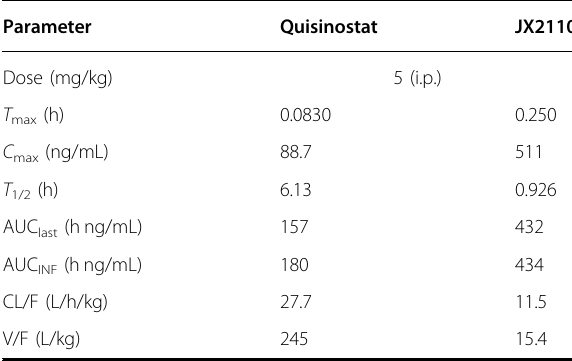
Table 2 In vivo pharmacokinetic parameters of quisinostat and JX21108 in